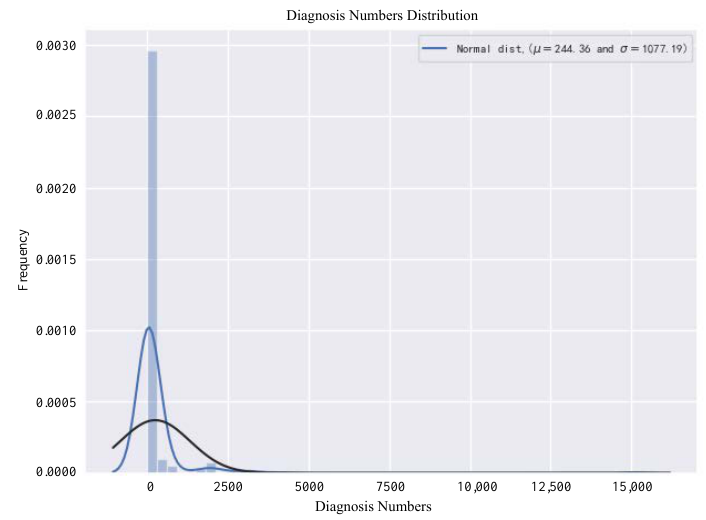
Figure 2. Original diagnosis numbers distribution diagram.